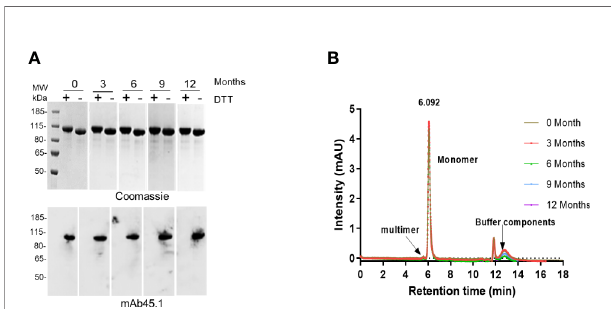
FIGURE 6 | Long term stability at -80°C. (A) Coomassie blue-stained 4% – 12.5% polyacrylamide gel; numerics Zero, 3, 6, 9, and 12 correspond to months ( upper panel ); an immune blot analysis of the same gel using mAb45.1 ( lower panel ). (B) SEC analysis (overlap chromatograms) of samples used in (A) Representative SEC chromatograms of R0.6C protein eluted contains the majority of